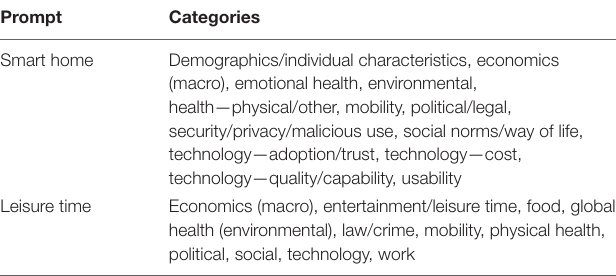
TABLE 3 | Categories of responses for the ANTA